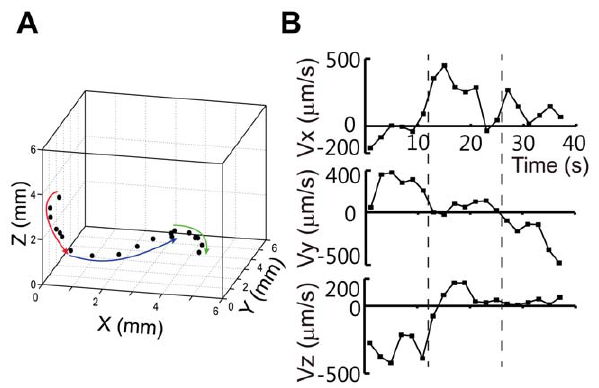
Figure 2. 3-D trajectory and velocity of a worm. (A) 3-D trajectory of the worm. Red, blue, and green arrows are movement directions of a worm for 12 s, 14 s, and 12 s, respectively. (B) The x-, y-, and z- components of the worm’s velocity. negative Y-direction for the last 12 s (green arrow) (Movie S2).